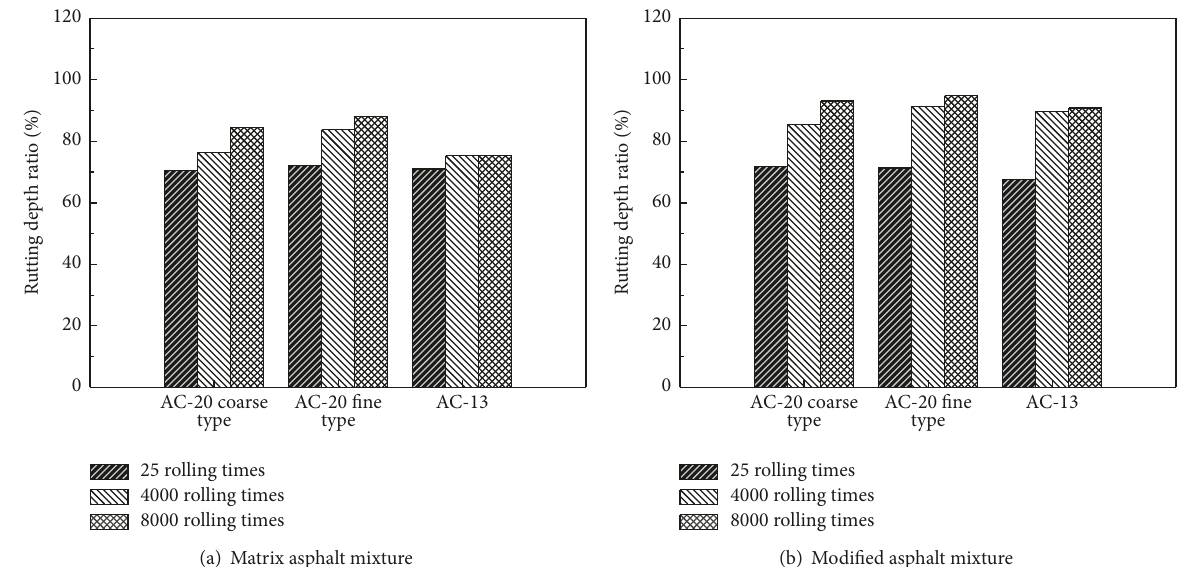
Figure 11: Rutting depth ratios of specimens with 7% air void at 60 ∘ C under different rolling